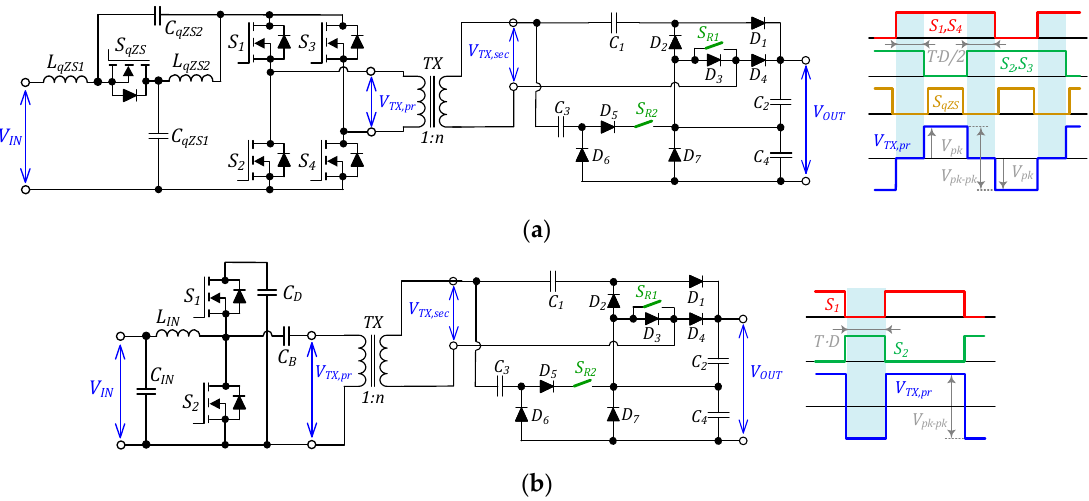
Figure 4. Case study high step-up converter topologies based on two BFEI types: ( a ) full-bridge quasi-Z-source inverter with symmetrical output voltage, ( b ) boost half-bridge with asymmetrical output voltage and idealized sketches describing the operation of each BFEI.